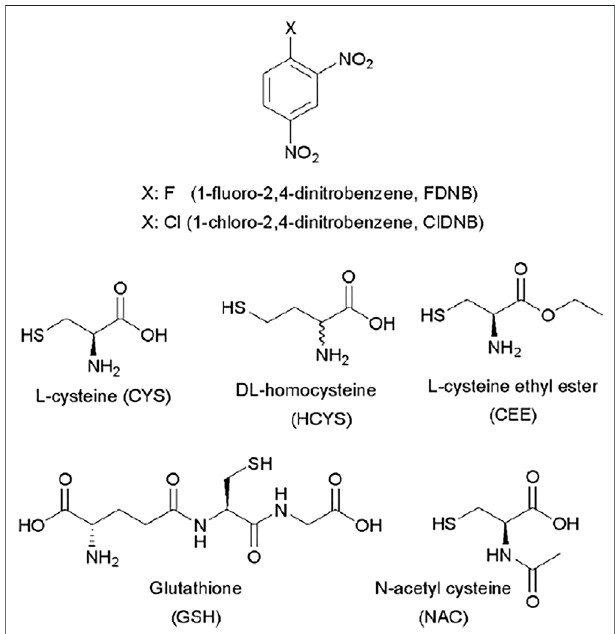
FIGURE 1 | Chemical structures of substrates and biothiols used in this